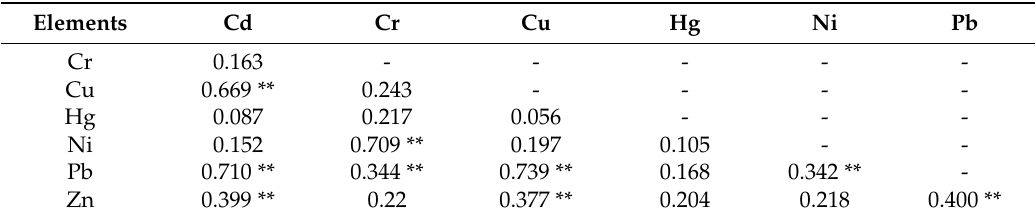
Table 5. Pearson correlation coefficients between element concentrations in moss samples from Taizhou.